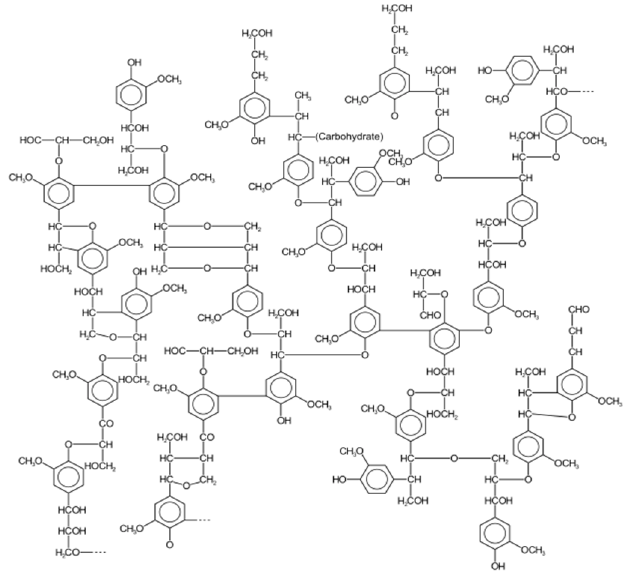
Figure 30. Model structure of lignin [428].